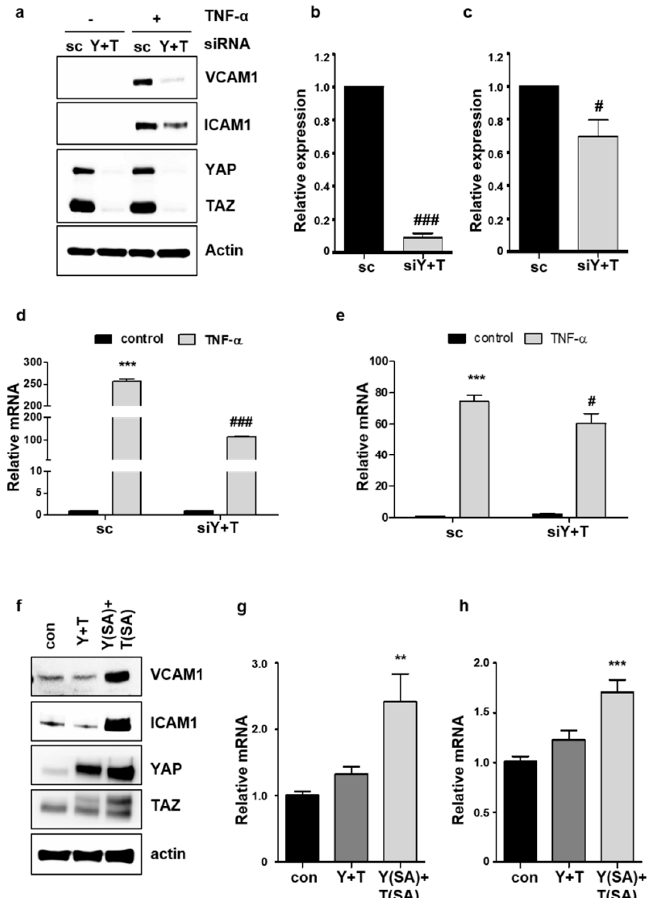
Figure 3. YAP mediates TNF- α -induced VCAM1 and ICAM1 expression in endothelial cells. ( a ) HUVECs were transfected with 25 nM control scrambled (sc) or YAP/TAZ (Y+T) siRNA. After 48 h, cells were treated with TNF- α for 6 h. VCAM1 and ICAM1 protein levels were assessed by western blot analysis. ( b , c ) Relative expression of VCAM1 ( b ) and ICAM1 ( c ) protein after TNF- α treatment was quantified. ( d , e ) HUVECs were transfected with sc or Y+T siRNA. After 48 h, the cells were treated with TNF- α for 24 h. The relative levels of VCAM1 ( d ) and ICAM1 ( e ) mRNA were determined by qRT-PCR. ( f ) Cells were co-transfected with control, YAP and TAZ, or YAP S127A and TAZ S89A overexpressing vectors. After 24 h, the cells were treated with TNF- α for 6 h. VCAM1 and ICAM1 protein expression was analyzed by western blot analysis. ( g , h ) The relative levels of VCAM1 ( g ) and ICAM1 ( h ) mRNA were determined by qRT-PCR. All experiments were repeated three times ( n = 3), and data are presented as the mean ± S.E. *** p < 0.001 and ** p < 0.01 vs. untreated scrambled siRNA-transfected control cells. ### p < 0.001 and # p < 0.05 vs. TNF- α -treated scrambled siRNA-transfected cells.